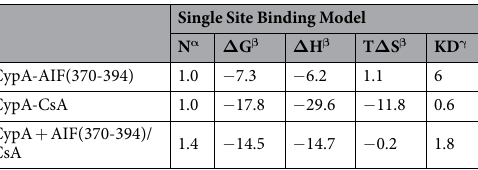
Table 2. Thermodynamic parameters associated with the binding of CypA with CsA and AIF(370-394). α Number of binding site, β Expressed in kcal/mol, γ Expressed in μ